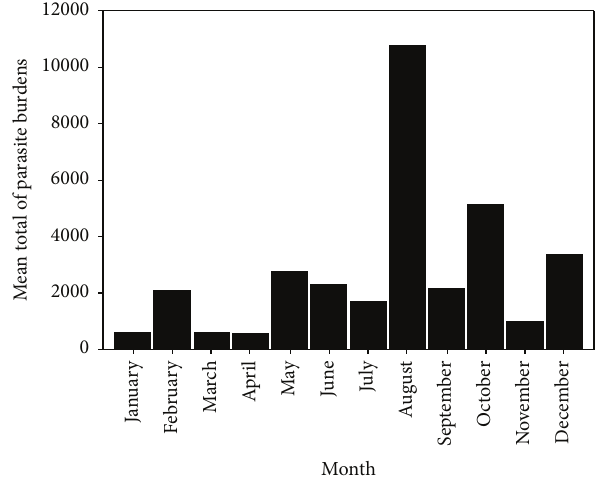
Figure 6: Monthly prevalence of parasite count among examined